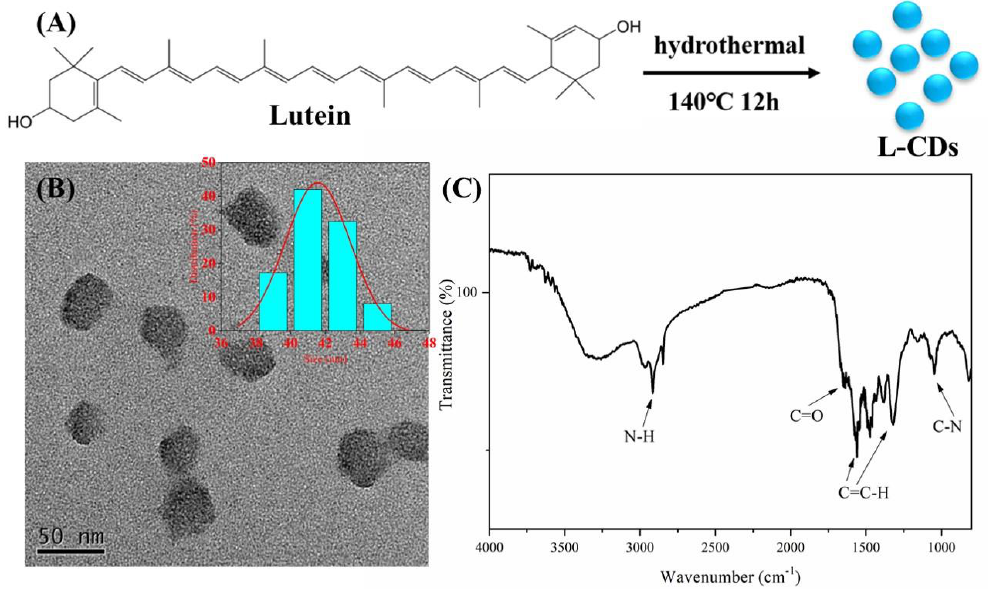
Figure 1. ( A ) Illustration of the formation process of lutein made into carbon dots (L-CDs) by hydrothermal treatment; ( B ) the transmission electron microscopy (TEM) images of L-CDs; ( C ) the Fourier transform infrared (FT-IR) spectrum of synthesized L-CDs.